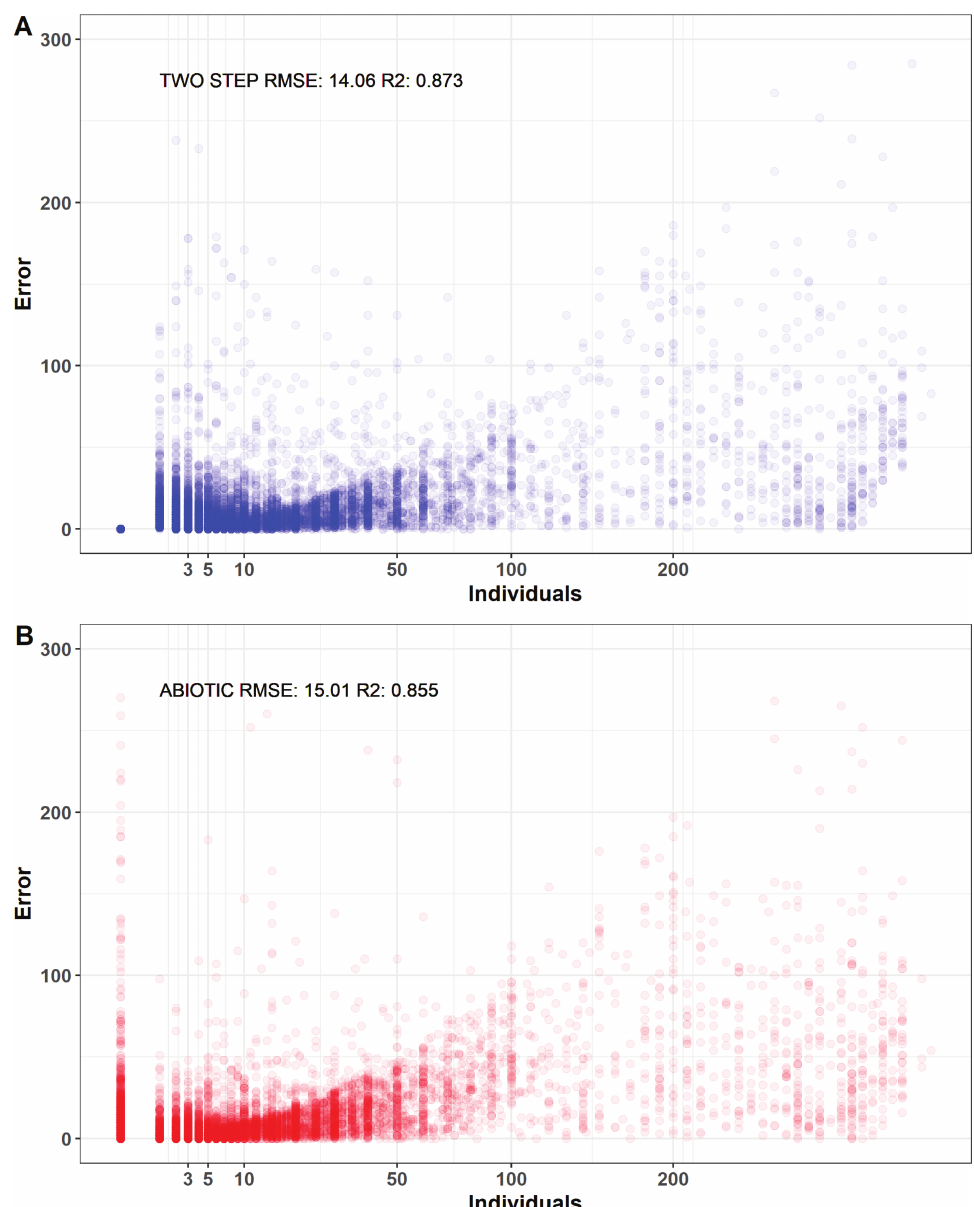
Fig 4. Prediction errors by individuals. Each dot is the value of j y (cid:0) ^ y j where y is the recorded value of abundance and ^ y the regression prediction. There are 37260 predictions for each run. A: Error values for a run of the two-step model with Random Forest. B: Error values for a run of the abiotic model with Random Forest.